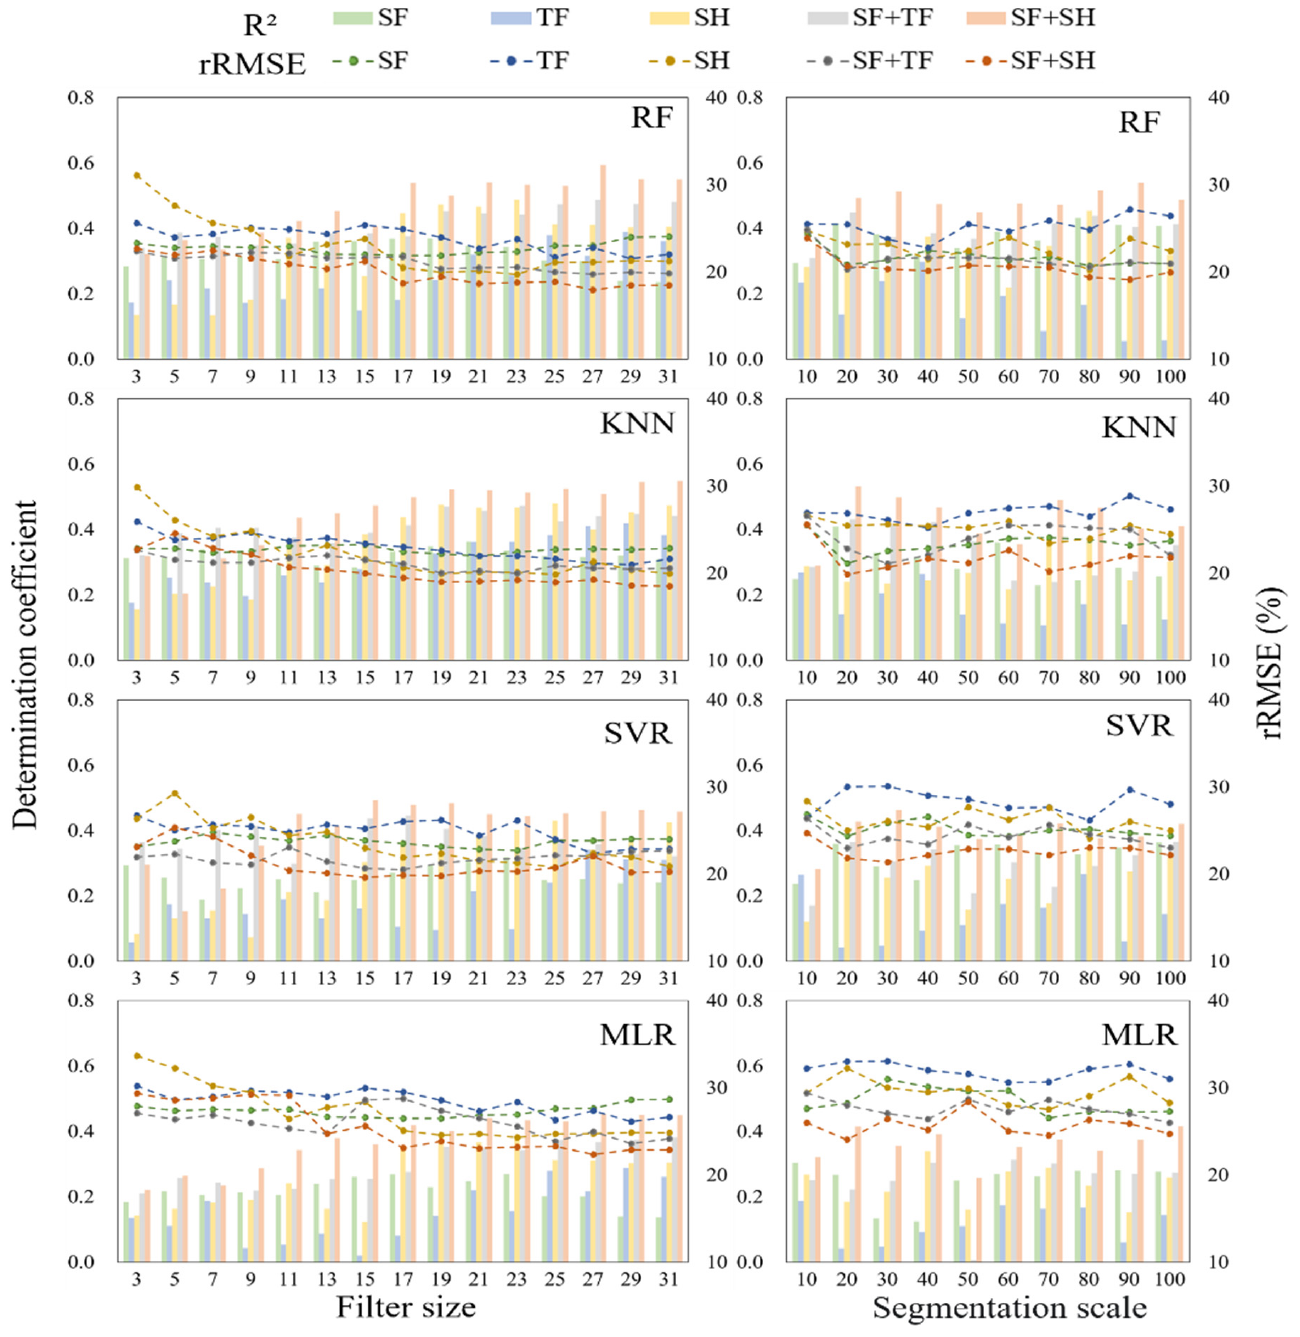
Figure 11. The accuracy of mapped tree CD values using four models with different feature extraction methods and their involved parameters.